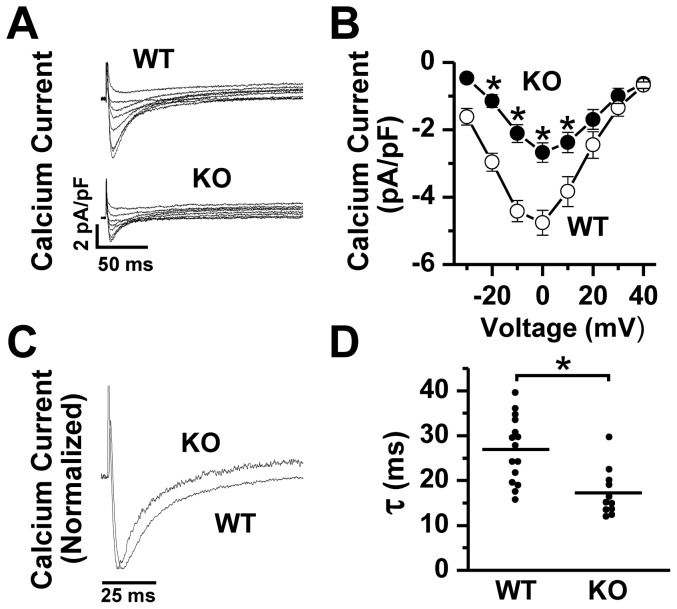
L-type calcium current in WT versus NCX1 KO SAN cells.
A. Raw traces showing L-type Ca current (normalized to cell capacitance) recordings from representative whole cell patch clamped WT and KO SAN cells depolarized from a holding potential of –40 mV to test potentials ranging from –30 to +40 mV at 10 mV intervals. B. Mean current-voltage plots (± SEM) showing a significant decrease in peak Ca current in KO (*P<0.05 by post-hoc analysis of 2-way ANOVA). C. Representative current traces from WT and KO cells during a depolarization to 0 mV (normalized to peak) illustrating accelerated inactivation kinetics in NCX1 KO cells, as summarized in the plots shown in panel D (*P<0.05 by t-test).